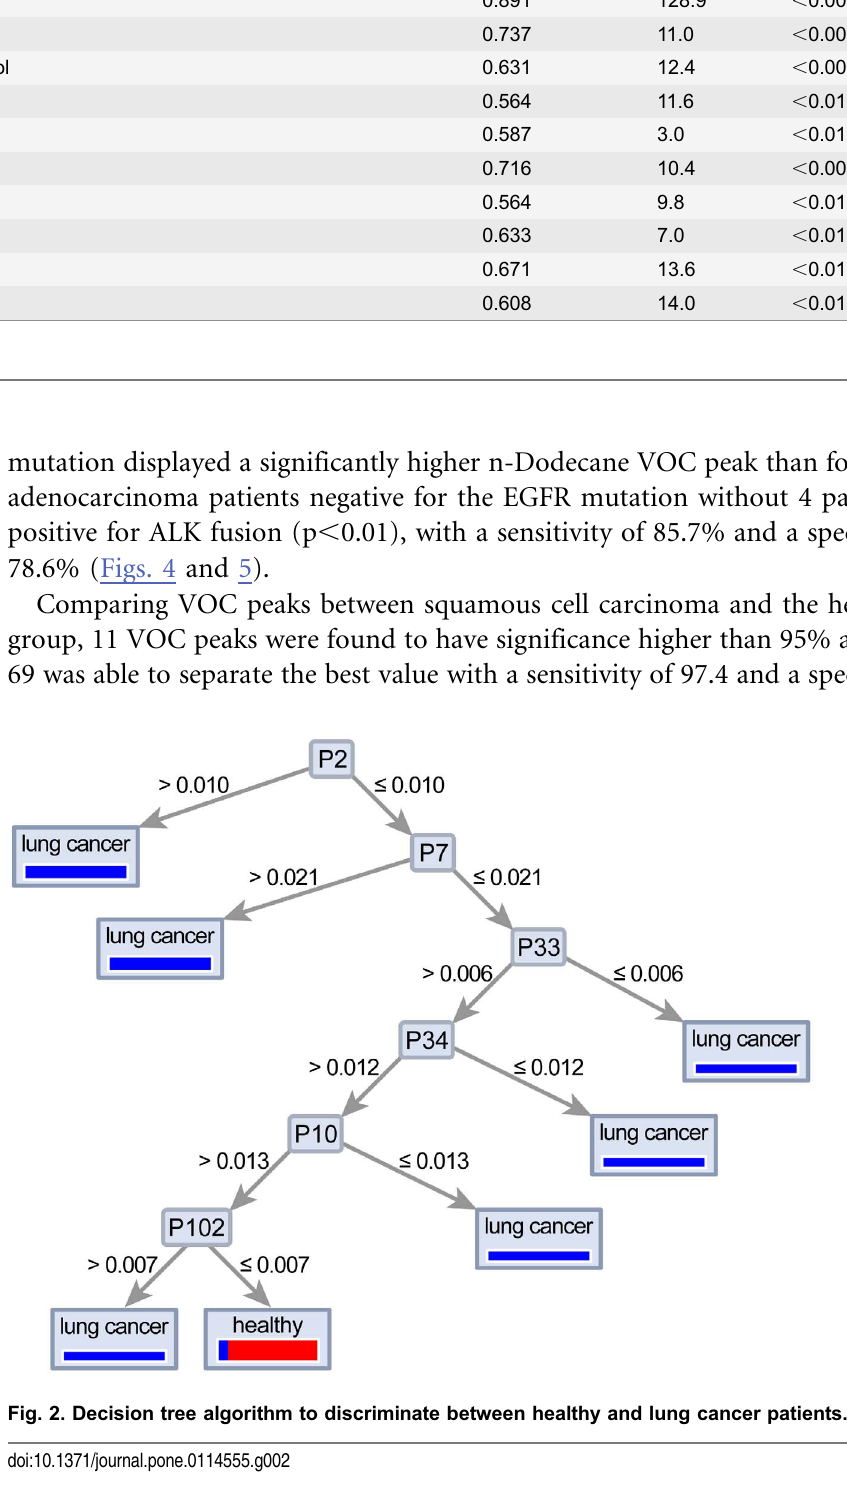
Fig. 2. Decision tree algorithm to discriminate between healthy and lung cancer